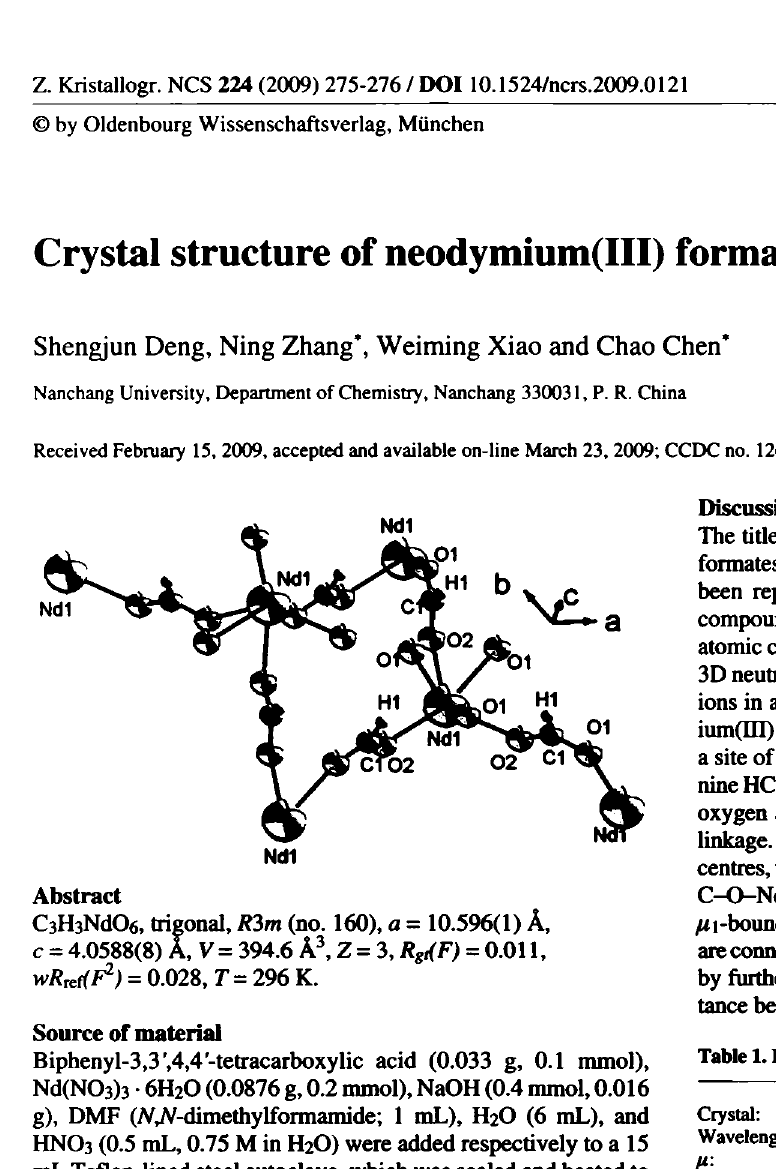
Table 2. Atomic coordinates and displacement parameters (in Â 2 ).